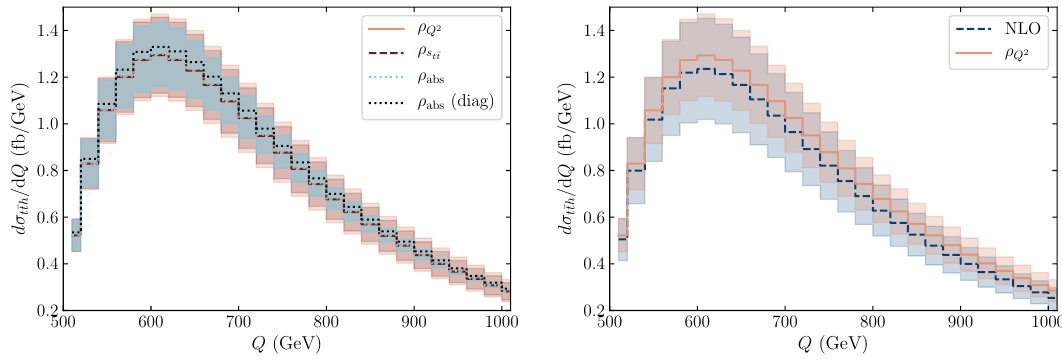
Figure 5 . Left: invariant-mass distribution of the matched resummed results using ρ abs with/without the approximated soft-anomalous dimension matrix (black and light-blue dotted), (red dashed) and ρ (orange solid). The colored bands indicate the total scale uncertainty ρ s Q 2 t ¯ t band, obtained by setting µ = µ , µ and µ , varying these between µ 2 and 2 µ , with µ Q high low ref / ref ref the reference factorization/renormalization scale, and picking the minimum and maximum value for each value of Q (eq. (5.2)). The central value is obtained by averaging these minimum and maximum values. The scale uncertainty band for ρ (diag) is not shown. Right: invariant-mass distribution abs of the NLO result (dark-blue dashed) and the matched resummed result obtained using ρ . Q 2 parameterizations. The scale uncertainties do differ, and the smallest scale uncertainty is found for ρ = ρ . By approximating the soft-anomalous dimension matrices we do abs find a noticeably different result of around +3% for all Q values. However, this difference lies well within the scale uncertainty of the results obtained without this